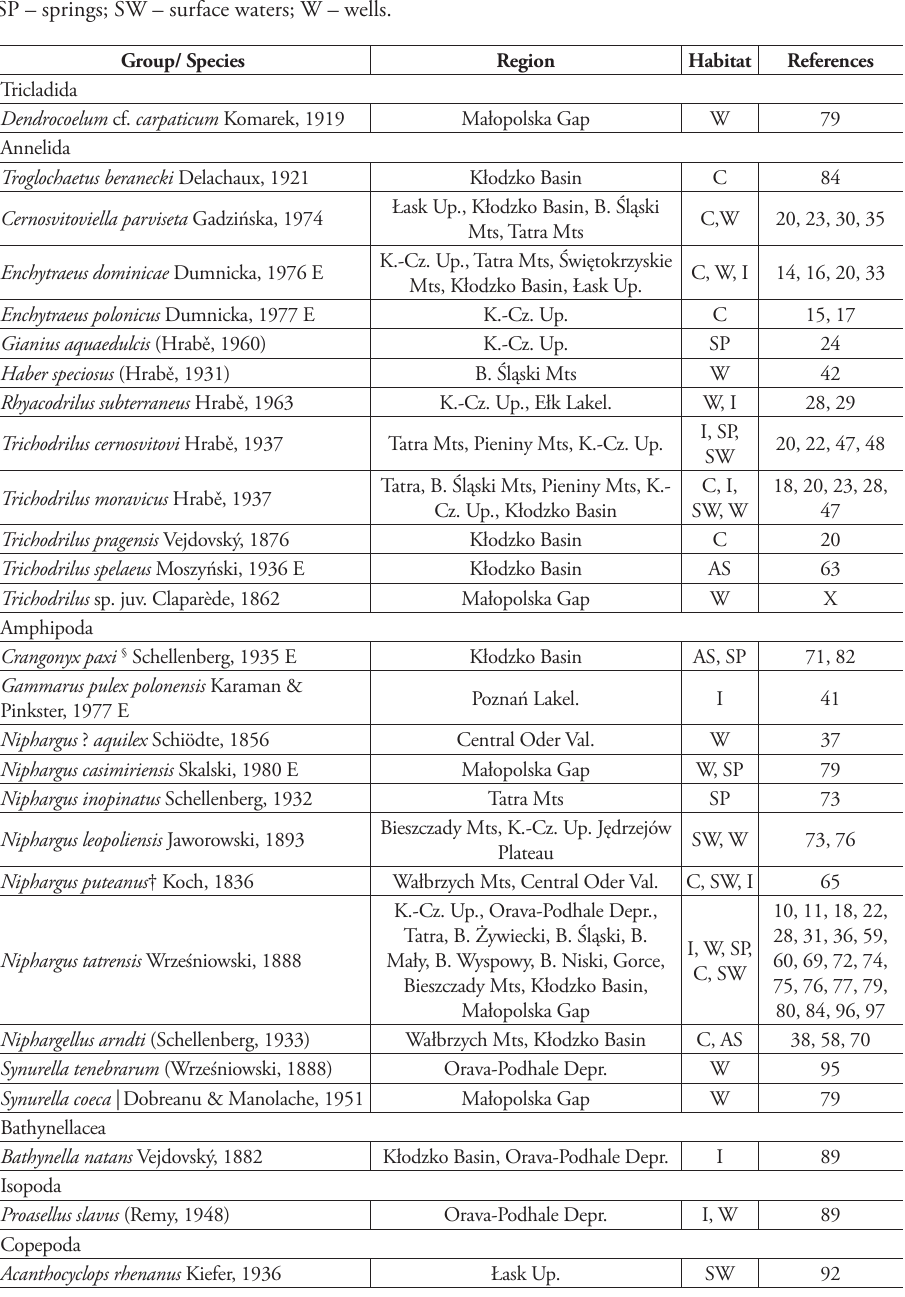
Table 1. List of stygobiontic species known of Poland and their association with the geographic re- gions and habitats. Abbreviations of geographic names: B. – Beskid Mts; K.-Cz. – Kraków-Częstochowa; Depr. – Depression; Lakel. – Lakeland; Up. – Upland; Val. – Valley. Abbreviations of habitat